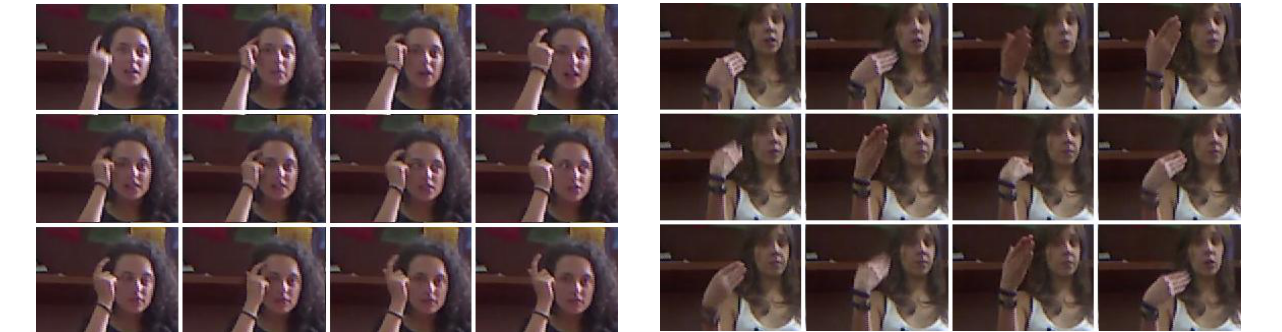
Figure 6. Sample00804, frames 216-251